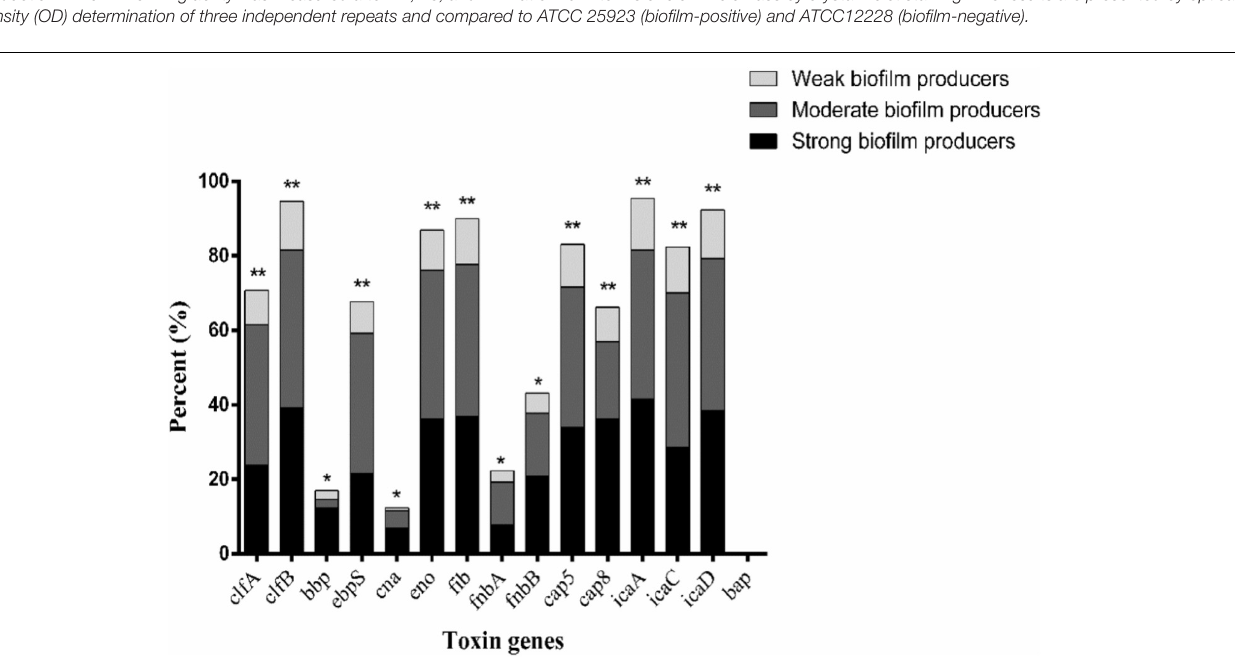
FIGURE 4 | Distribution of biofilm-associated genes of S. aureus isolates based on biofilm formation ability. Pearson’s chi-square test (two-tailed) was used to test the difference in the virulence determinants distribution among different ability of biofilm ability. ∗ Demonstrates that the distribution of toxin genes was statistically significantly different ( p < 0.05); ∗∗ demonstrates that the distribution of toxin genes was more significantly different ( p <